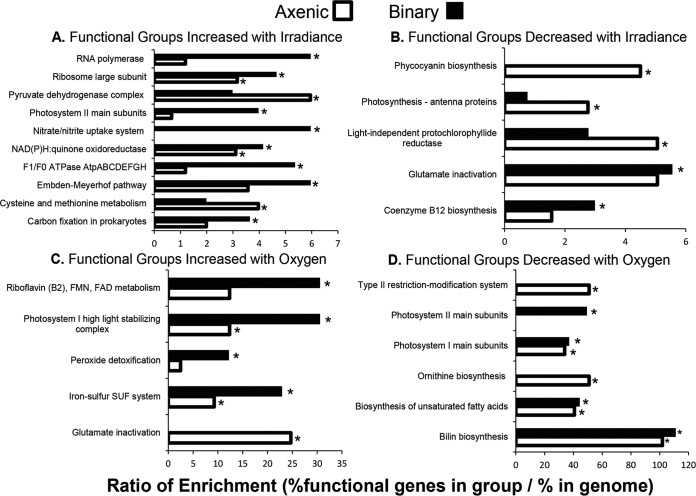
Enriched gene functions responding to irradiance and pO2. Ratios on the x axis depict the percentage of genes of a particular function (shown on the y axis) in a given category (e.g., RNA polymerase genes increasing their expression with irradiance under binary conditions, top black bar of the upper left figure) divided by the percentage of genes of the same function in the genome as a whole. For comparison, the ratios of functional enrichment are shown for both axenic (white) and binary (black) cultivation with at least one of the two being significantly enriched with a P value of <0.05 as determined by Fisher’s exact test (indicated by *). (A) Functional groups that increased with increasing irradiance. (B) Functional groups that decreased with increasing irradiance. (C) Functional groups that increased with increasing O2 tension (pO2); SUF, sulphur assimilation. (D) Functional groups that decreased with increasing O2 tension. FMN, flavin mononucleotide; FAD, flavin adenine dinucleotide.